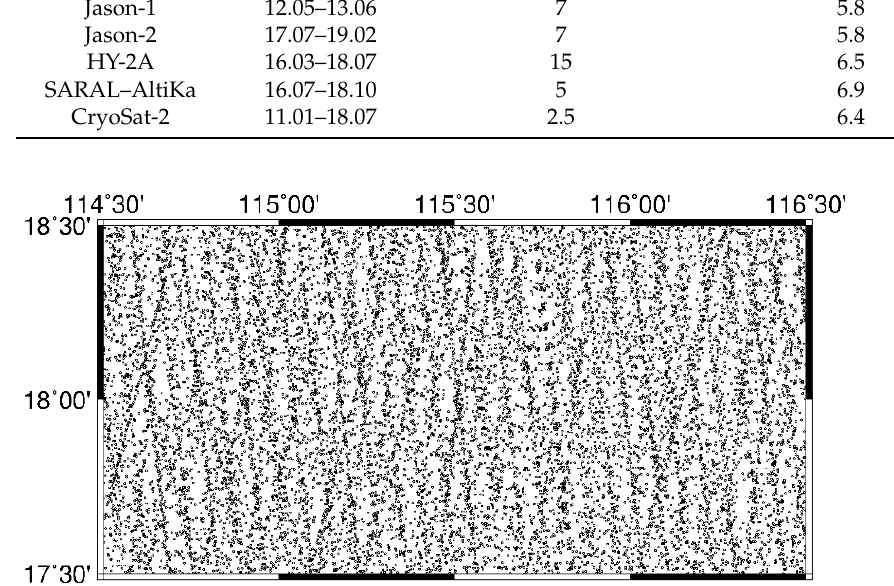
Figure 2. Tracks of altimetric data used to determine altimetric gravity anomaly model around the South China Sea (SCSGA) V1.0. Table 3. Differences between SCSGA V1.0 and shipborne data since 1990 in shallow waters.